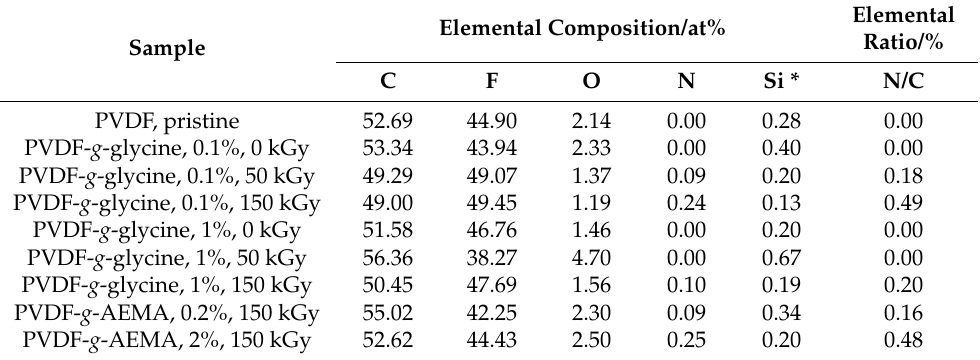
Table 1. XPS investigations of pristine PVDF membrane and PVDF modified with glycine (mass fractions ω = 0.1–1% and dosages of 0, 50, and 150 kGy), as well as AEMA immobilization (RIGP mechanism) in comparison.